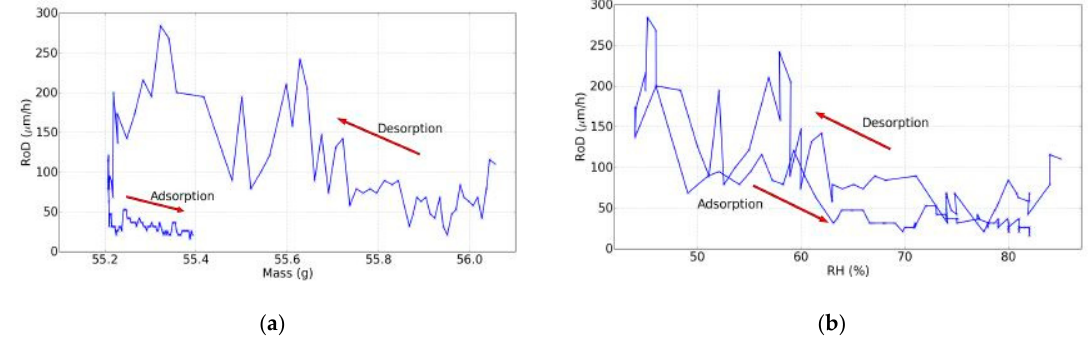
Figure 11. ( a ) The RoD as a function of the mass and ( b ) the RoD as a function of the RH (day 7).